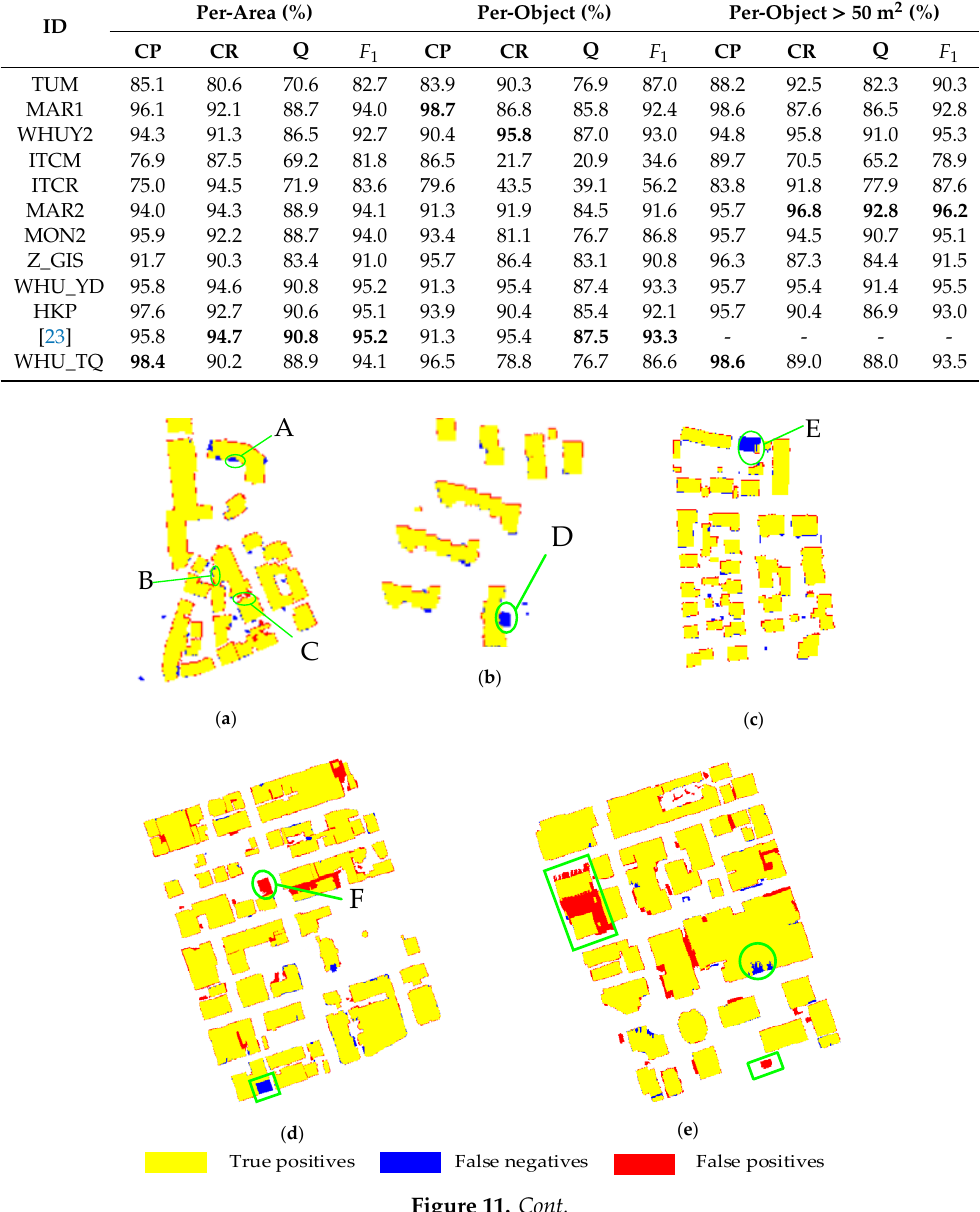
Table 3. Average evaluation results comparison of the building extraction (Area 4 to 5). (The best values per column are shown in the bold font.).